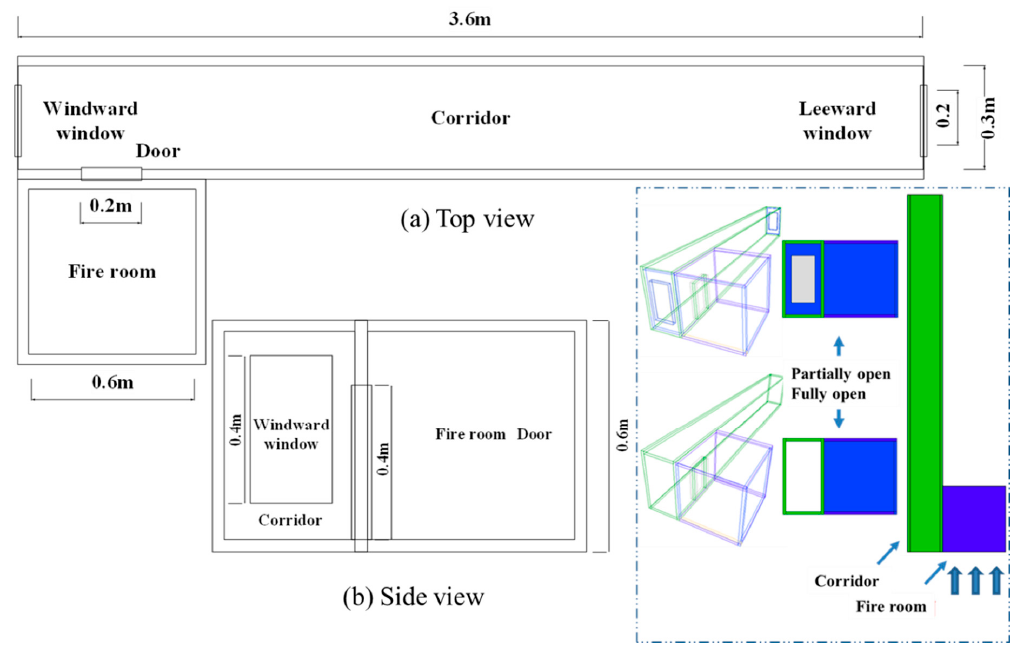
Figure 2. Schematic diagram and detailed dimensions of model-scale building structure: ( a ) top view; ( b ) side view.